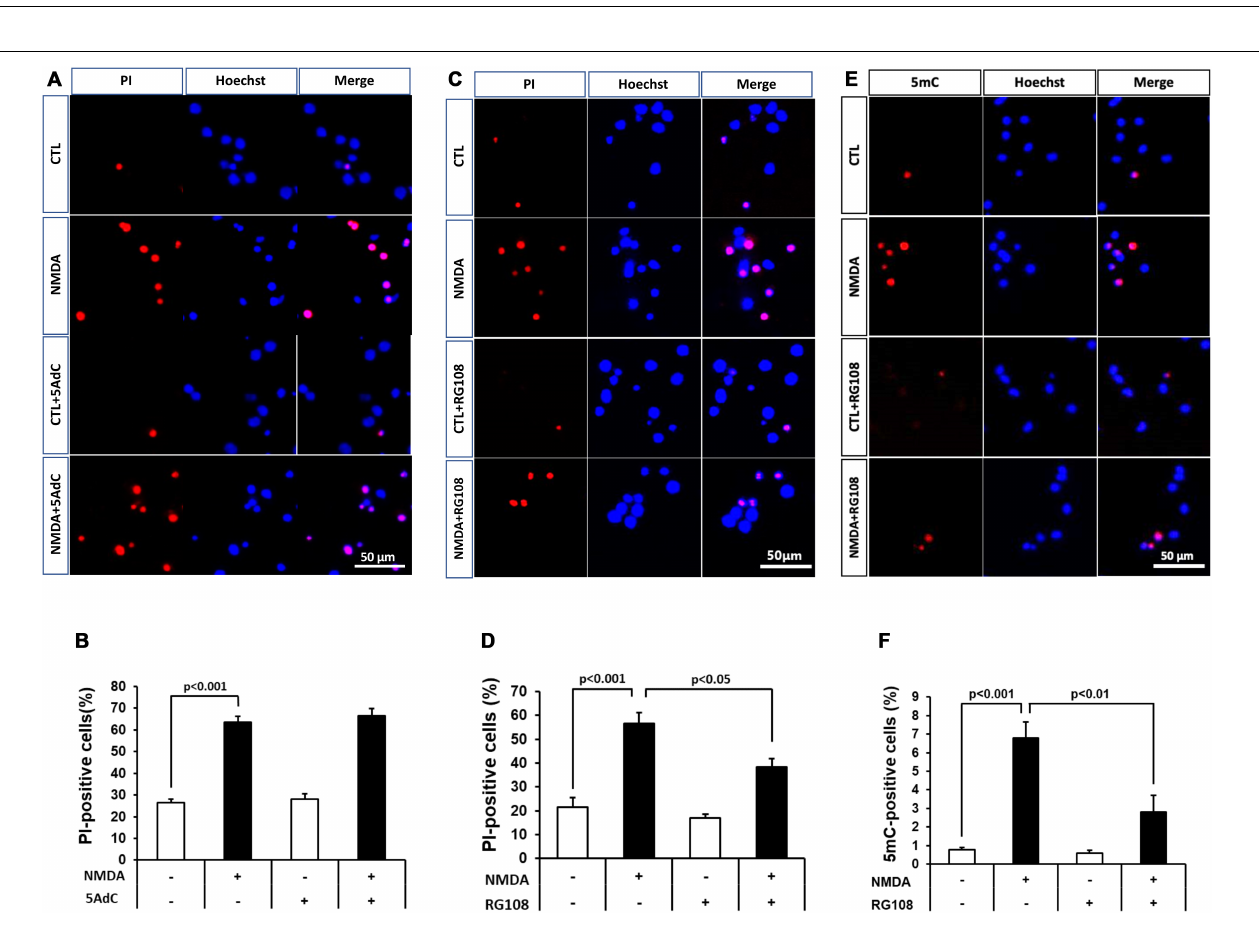
FIGURE 5 | (A,C,E) Time course of changes in the protein levels of DNMT1 (A) , DNMT3a (C) , and DNMT3b (E) in cortical neurons in primary culture after NMDA (closed triangle) or vehicle (open circle) treatment. (B,D,F) Comparison of the protein levels [DNMT1 (B) , DNMT3a (D) , and DNMT3b (F) ] in NMDA-treated group and vehicle-treated control group at 4 h of treatment. These DNMTs and β -actin bands were scanned, and the scanned bands were normalized by the non-treated control on the same blot. β -Actin was used as a loading control. Results are the means ± SD ( n = 4–5 independent experiments). (G–J) Changes in the mRNA expression levels of DNMT1 (G) , DNMT3a (H) , DNMT3b (I) , and UHRF1 (J) at 30 min of treatment. Results are the means ± SD ( n = 4 independent experiments). (K–M) Changes in the mRNA expression levels of DNMT1 (K) , DNMT3a (L) , and DNMT3b (M) at 4 h of treatment. Results are the means ± SD ( n = 5 independent